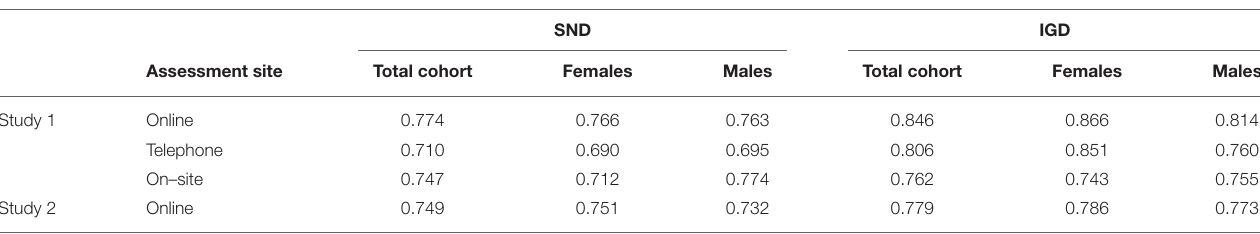
TABLE 2 | Cronbach’s α depending on assessment site and